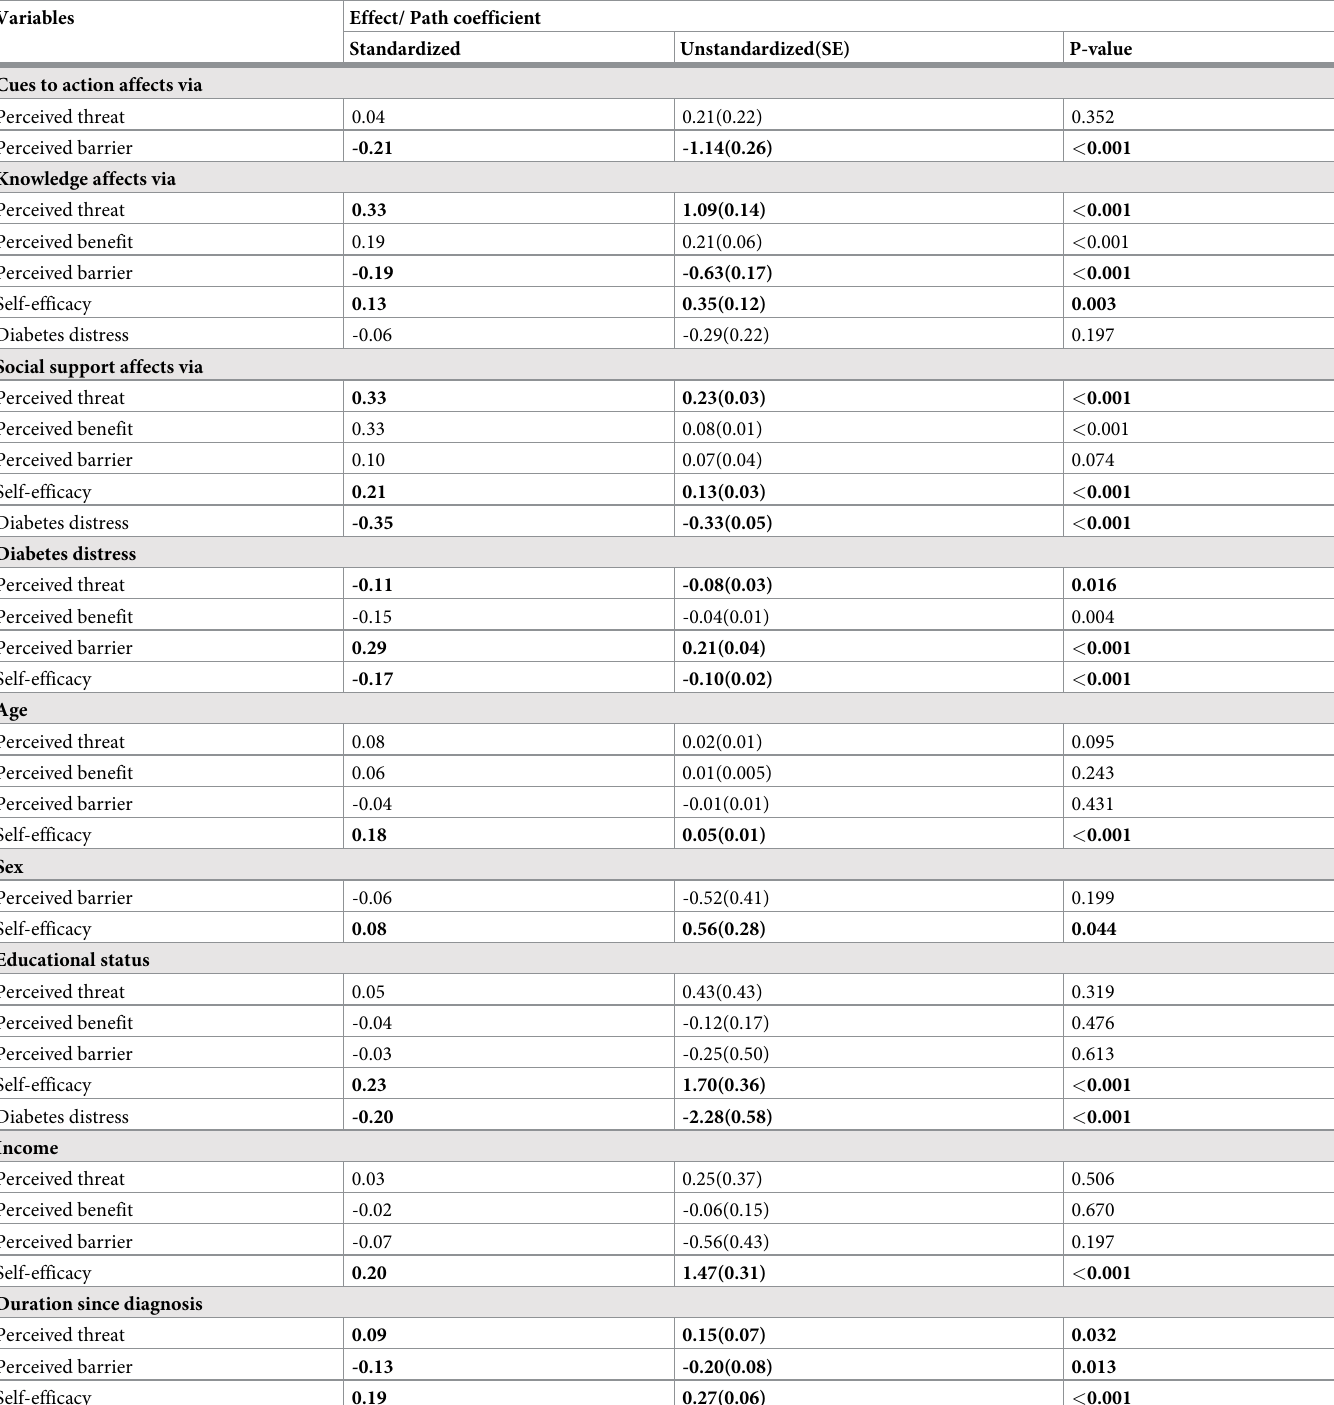
Table 7. Decomposition of modifying factors indirect effects on dietary practice, JUMC 2020.